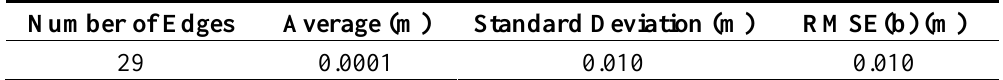
Table 9. Relative positional accuracy analysis for the Presidente Prudente Railway Station